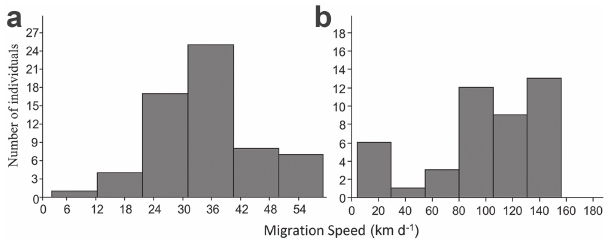
Fig. 2. Distribution of migration speed (km d -1 ) of Prochilodus costatus in a. up and b. downstream migration of tagged fish.